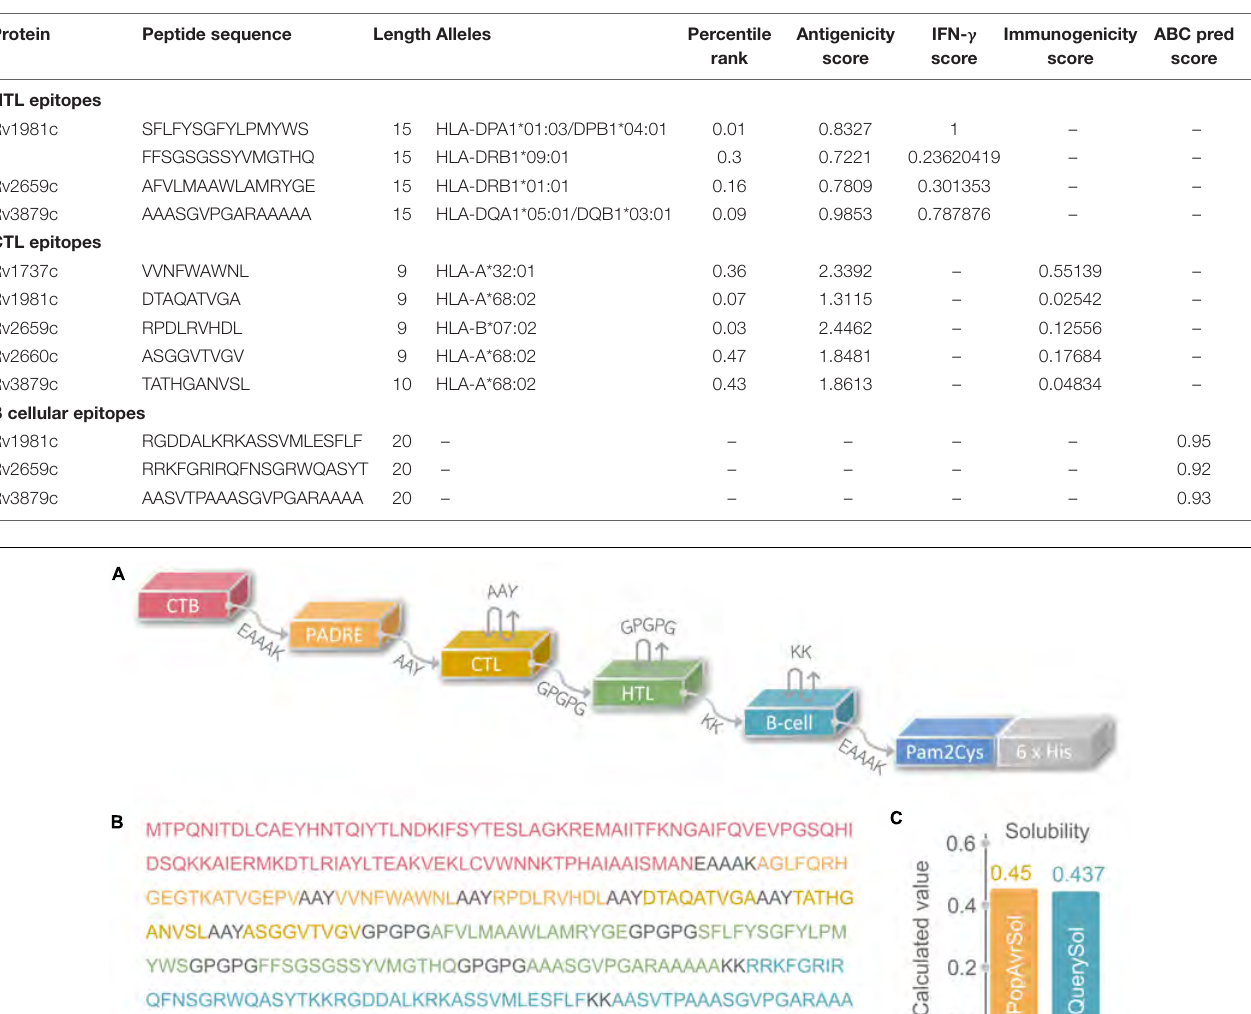
TABLE 2 | Overall the HTL, CTL, and B-cell epitopes selected to construct the C543P candidate. Protein Peptide sequence